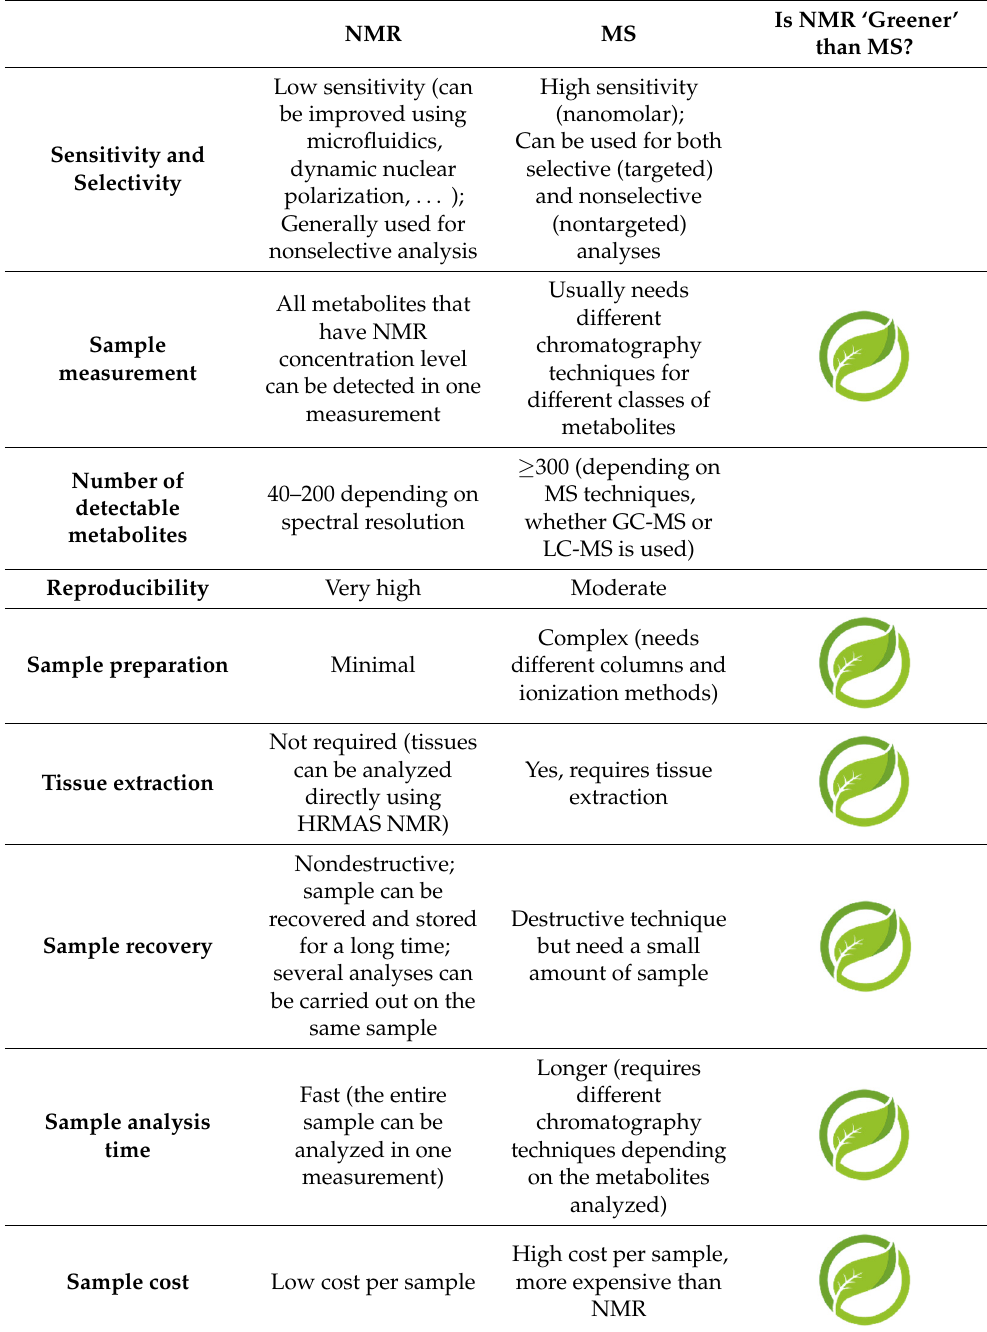
Table 1. Key differences between NMR and MS as green tools for metabolomics research (adapted from Emwas [17]).